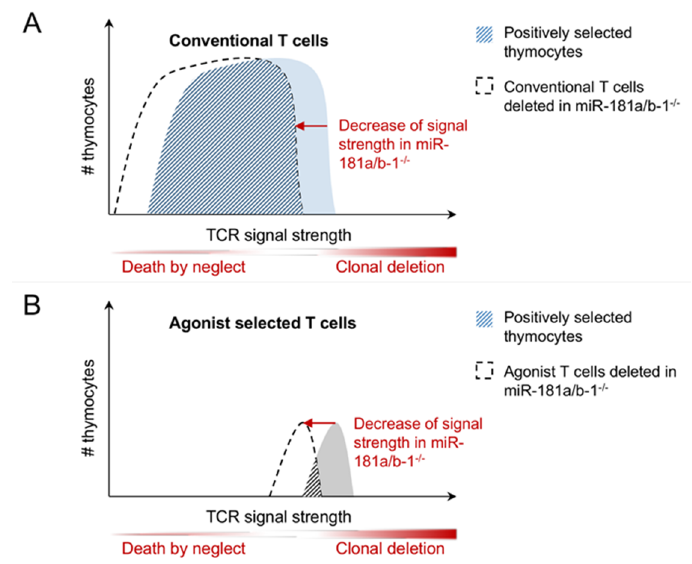
Figure 3. Hypothetical function of miR-181a/b-1 as rheostat for TCR signaling during selection. ( A ) How miR-181 affects conventional T cells: Due to their broad affinity window, the effect of the shift in TCR signal strength on selection is relatively small. ( B ) How miR-181 affects agonist selected T cells: Due to their high and narrow affinity window, the effect of the shift in TCR signal strength on selection is evident.